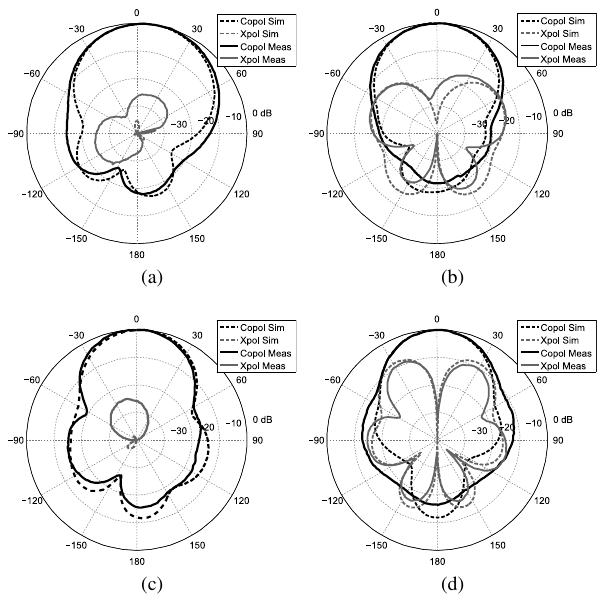
FIGURE 21. Radiation patterns for the final optimized frequency reconfigurable E-shaped patch antenna. (a) OFF state, 2.05 GHz, E-plane. (b) OFF state, 2.05 GHz, H-plane. (c) ON state, 2.8 GHz, E-plane. (d) ON state, 2.8 GHz, H-plane. Adapted from